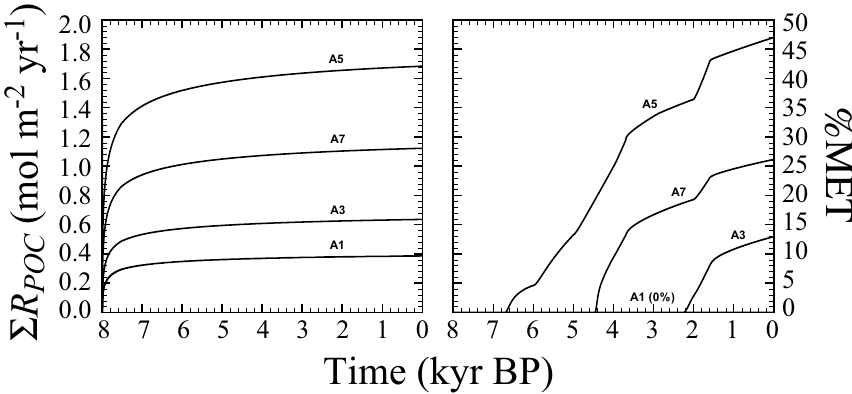
Fig. 11. Left panel: development in time of depth-integrated POC degradation rates ( P R POC ). Right panel: percentage of degradation channeled towards methanogenesis for the Stations A3, A7, and A5. A1 is not plotted since no methane forms at this station.